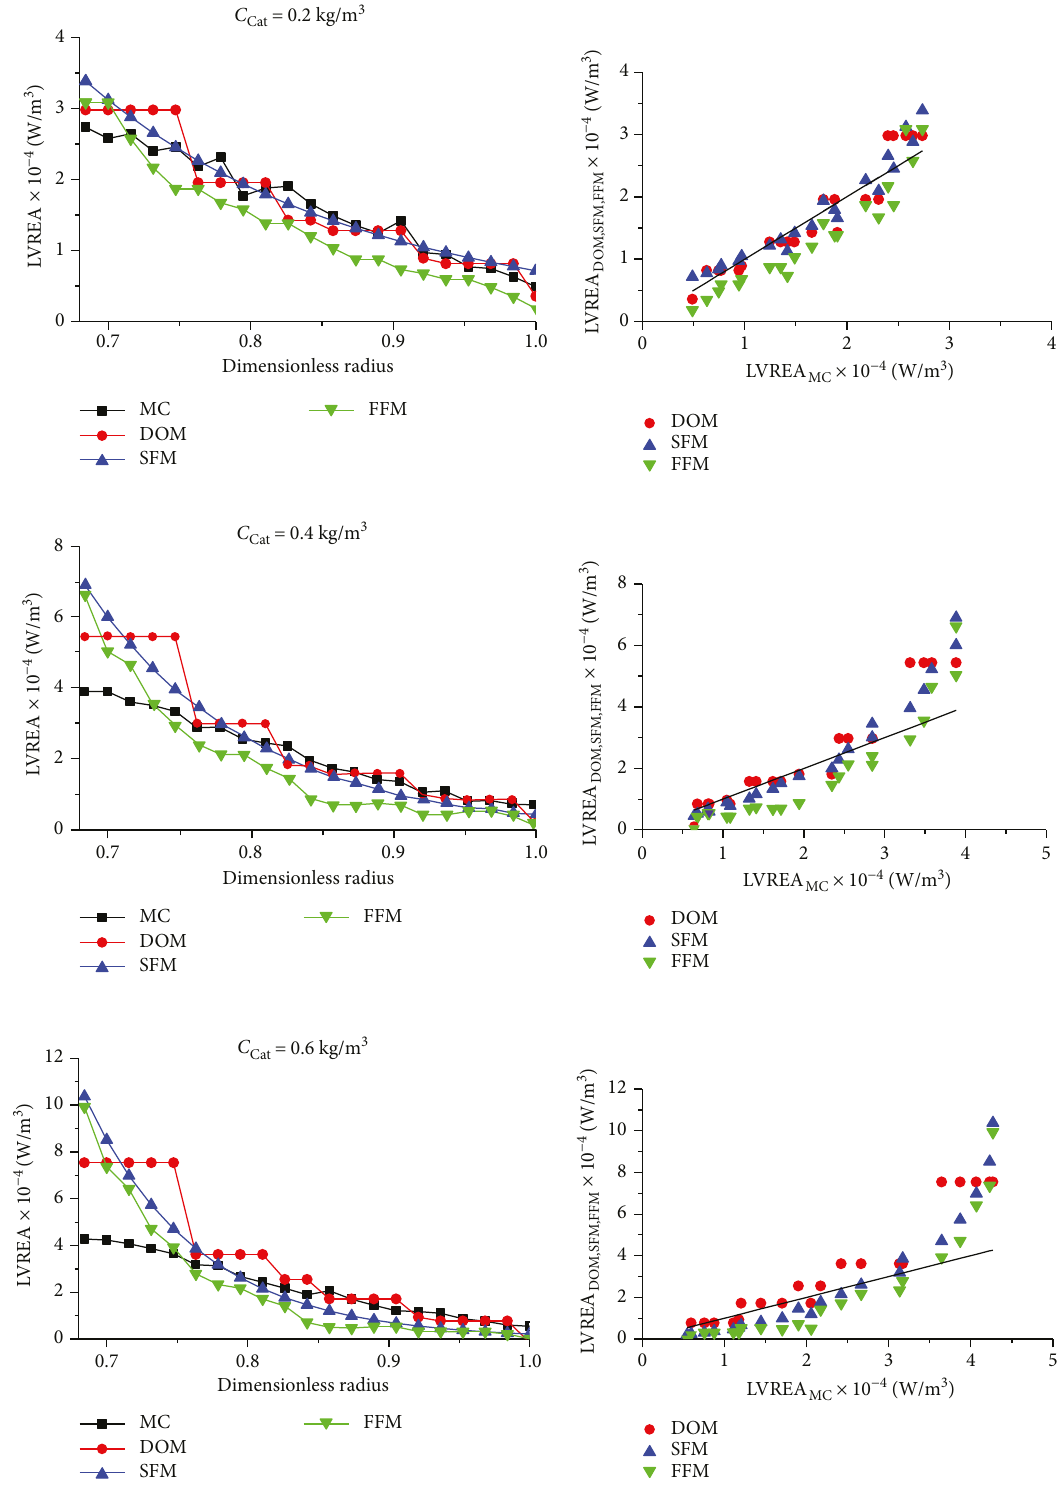
Figure 6: Radial pro fi les of local volumetric rate energy absorption (LVREA) obtained with four- fl ux model at di ff erent concentrations of catalyst for system 1 and its comparison with the other